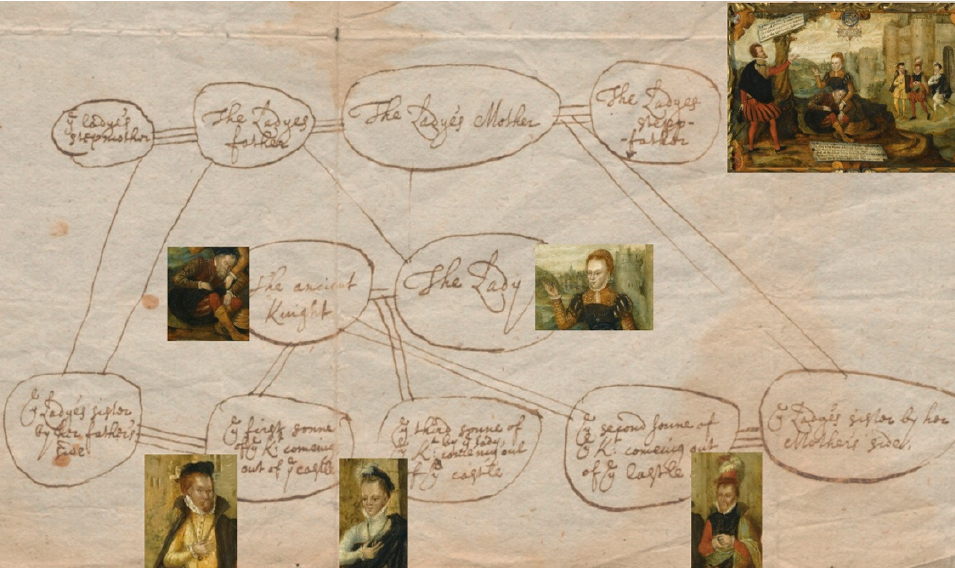
Figure 13. ‘The L[or]d Treasurer Burleigh’s riddle for Consanguinity’, The William Andrews Clark Memorial Library, University of California, Los Angeles, shown with the inset figures from the riddle painting ‘devoted’ to Sir William Cecil, Hatfield House, Hertfordshire, UK, courtesy of the Marquess of Salisbury.